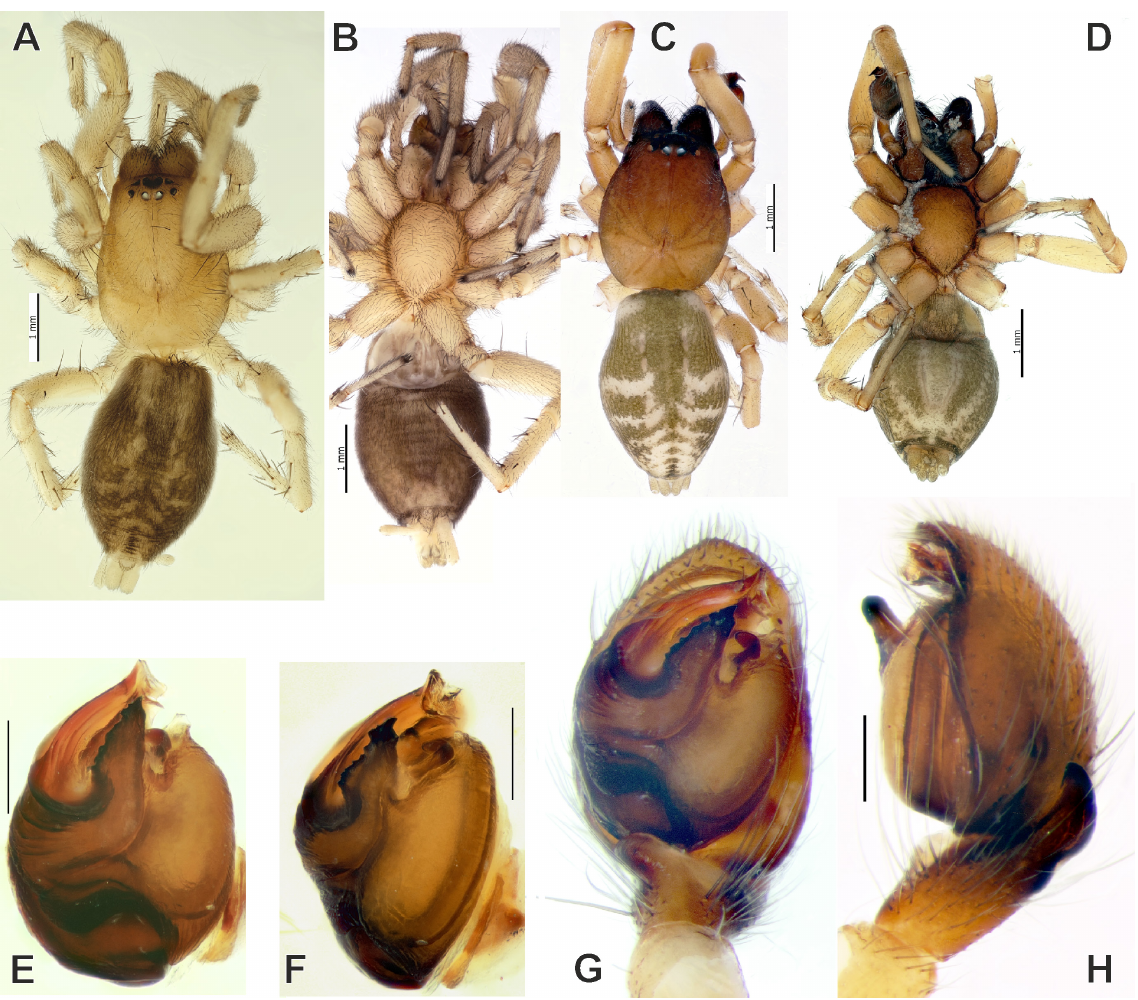
Fig. 12. Haplodrassus qashqai sp. nov. (A–B = paratype, ♀ from Lorestan Province, MHNG; C–H = holotype, ♂, MHNG). A, C . Habitus, dorsal view. B, D . Habitus, ventral view. E–F . Bulb, ventral and proventral views. G–H . Palp, ventral and retrolateral views. Scale bars: 0.2 mm, unless stated